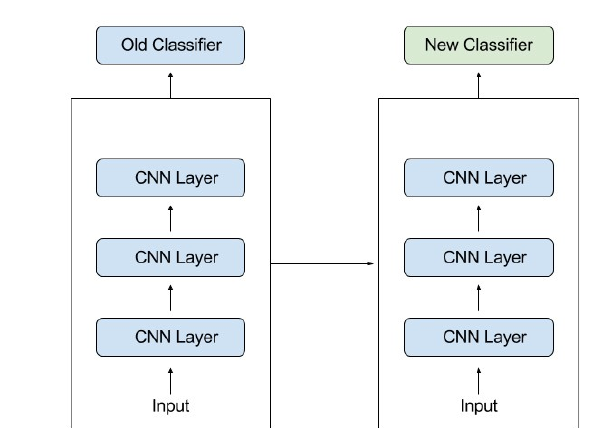
Fig. 1. Visual representation showcasing the idea of transfer learning